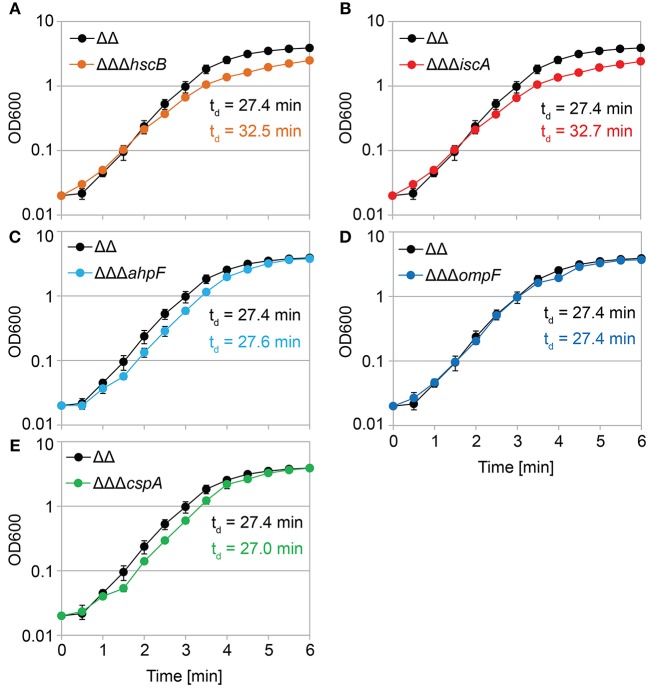
Growth in liquid medium is impaired by hscB and iscA deletions. Growth curves of double deletion strain Δ1-41 ΔistR (ΔΔ) and corresponding triple deletion strains in liquid LB medium. The OD600 was initially adjusted to 0.02 from over-night cultures and measured over 6 h. Doubling times (td) during exponential phase are given for the corresponding strains in each graph. (A) ΔΔ vs. ΔΔΔhscB, (B) ΔΔ vs. ΔΔΔiscA, (C) ΔΔ vs. ΔΔΔahpF, (D) ΔΔ vs. ΔΔΔompF, and (E) ΔΔ vs. ΔΔΔcspA. Data represent the mean of at least three independent biological replicates. Error bars depict standard deviations.